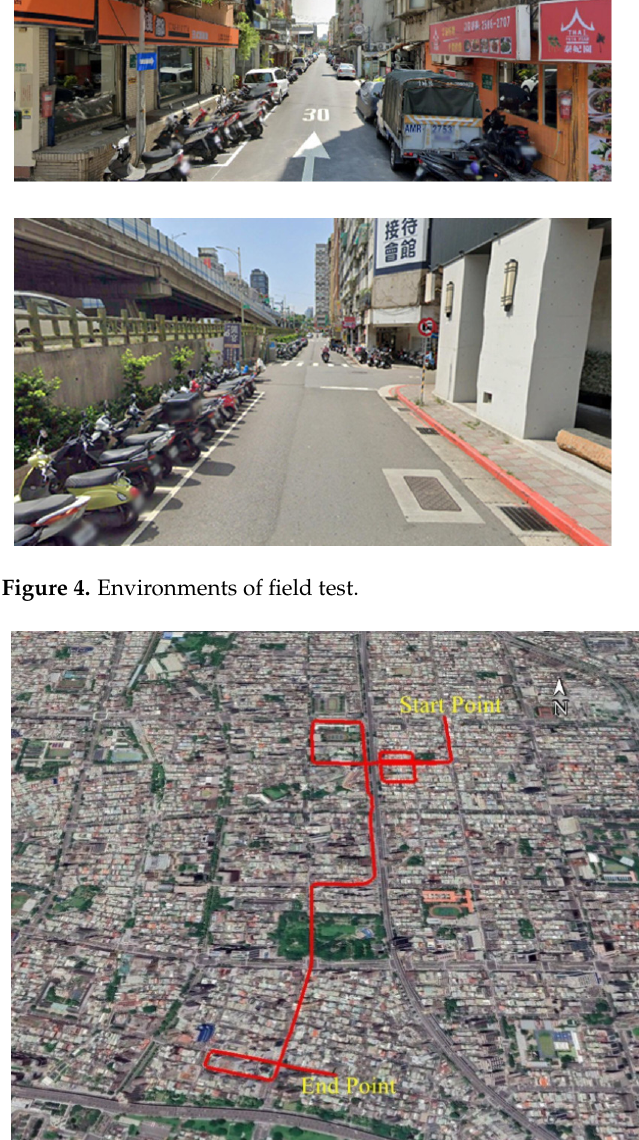
Figure 6. PDOP in field test. Figure 7. Visible satellite number in field test. 355,743